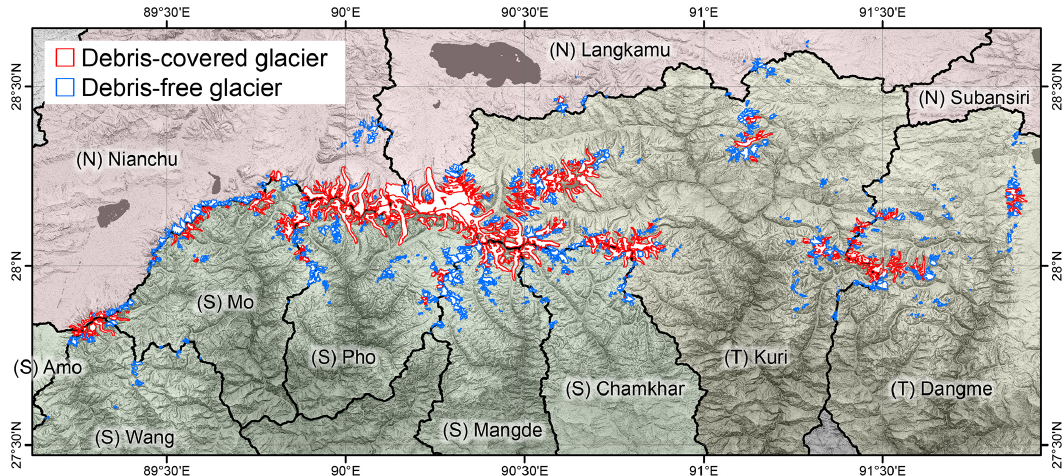
Figure 1. Glacier distribution of the ALOS-derived glacier inventory in the Bhutan Himalaya, in which glaciers are categorised into debris- covered and debris-free glaciers. Eleven river basins are categorised into (N) northern, (T) traversal, and (S) southern basins. The background is a hillshade image derived from the ASTER GDEM2.